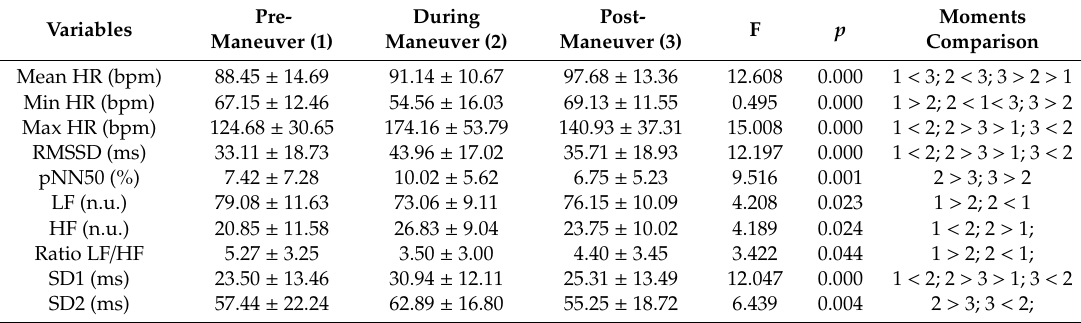
Table 2. Changes (M ± SD) in the autonomic response (HRV) pre-, during, and post-maneuver. Pre- Variables Maneuver